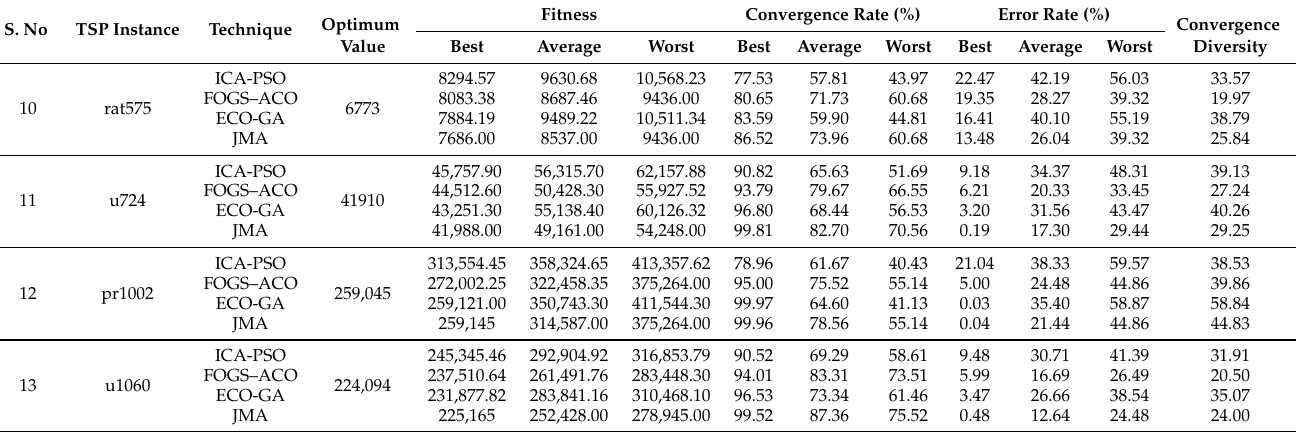
Table 11. Large-scale TSP